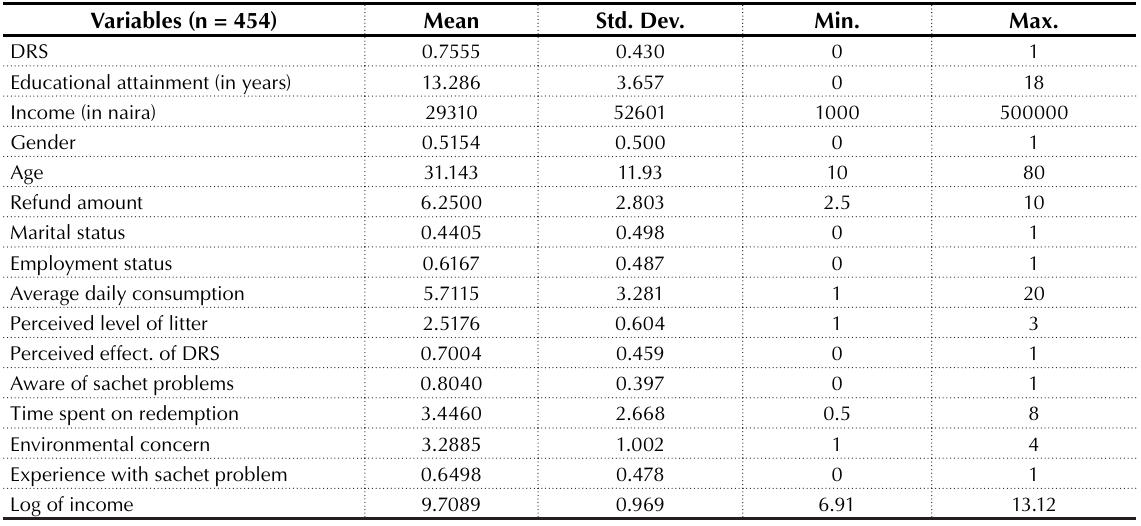
Table 6. Summary statistics for logit regression